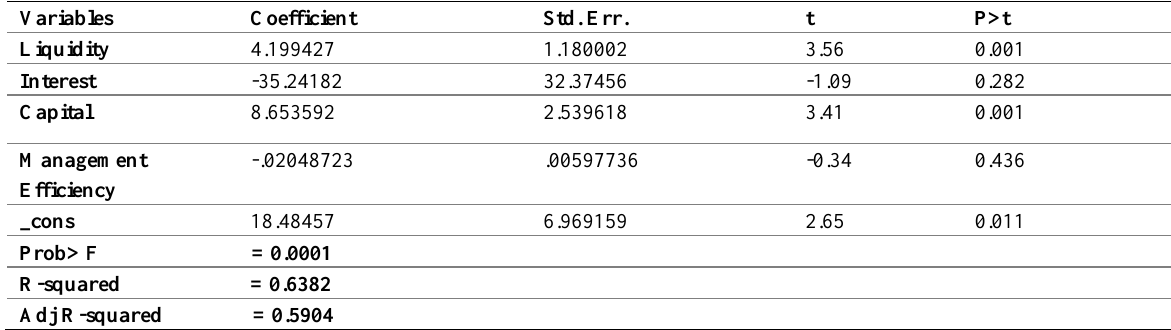
Table 6: Multiple Regressions